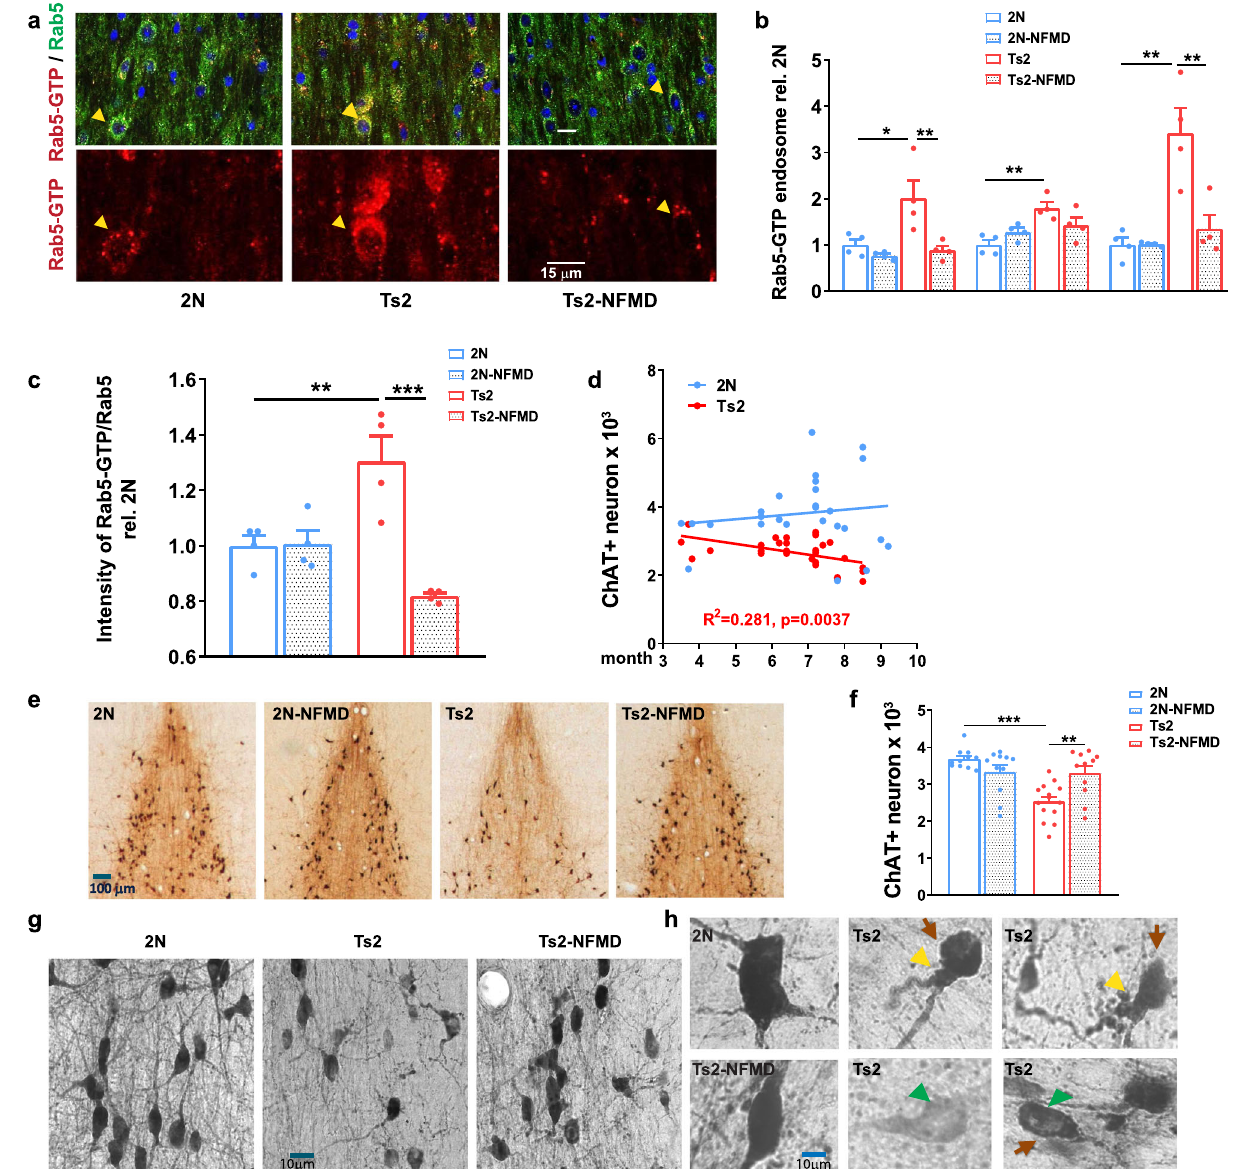
Fig. 1 | Normalized Rab5+ endosome number/size and restored cholinergic neuronal numbers in Ts2 mice treated with ne fl amapimod (NFMD). a Representative images of medial septal nucleus (MSN) regions from vehicle- treatedwildtype(2N, n =4),vehicle-treatedTs2( n =4)andNFMD-treatedTs2(Ts2- NFMD) mice, labeled with Rab5-GTP (red) and Rab5a (green) antibodies; arrows point to the Rab5-positive neurons, which are shown enlarged in the lower panel (scalebar,15 μ m). b Thenumbers,sizesandareasofRab5-GTP-positiveendosomes determined by Image J analysis [ n =4 mice per group; for number: F(3,12)=7.789, R square=0.661; for 2N vs Ts2 p =0.0202, 95% CI= − 1.880, − 0.151; for Ts2 vs Ts2- NFMD p =0.0097, 95% CI=0.273, 2.002; for size: F(3,12)=6.939, R square=0.634, for 2N vs Ts2 p =0.0036, 95% CI= − 1.329, − 0.269; for area: F(3,12)=13.19, R square=0.767; for 2N vs Ts2 p =0.0009; 95% CI= − 3.766, − 1.079; for Ts2 vs Ts2- NFMD p =0.0030, 95% CI=0.7325, 3.419]. c The ratio of Rab5-GTP to total Rab5 intensities determined with Image J [ n =4 mice per group; F(3,12)=13.23, R square=0.768; for 2N vs Ts2 p =0.001, 95% CI= − 0.537, − 0.073; for Ts2 vs Ts2- NFMD p =0.0002, 95%CI=0.254, 0.719]. d The number of stereologicallycounted